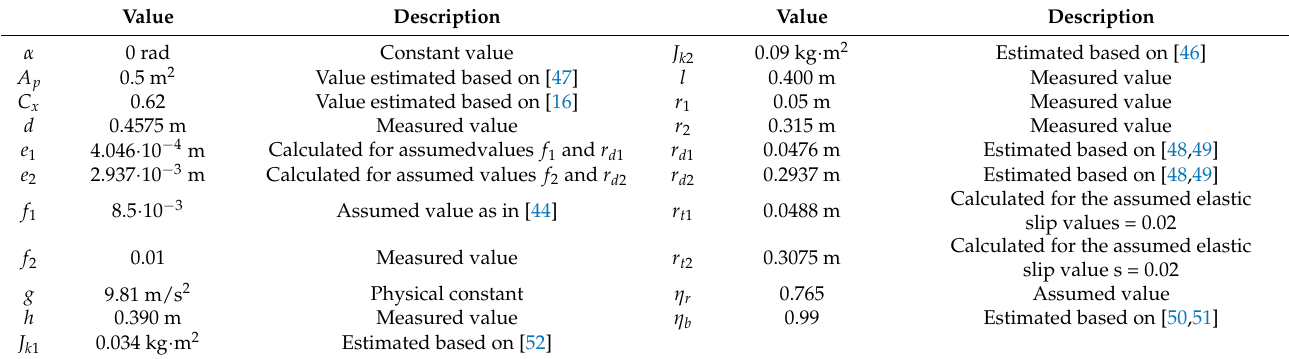
Table 1. Model parameters adopted for the simulation; similar values were used to those in